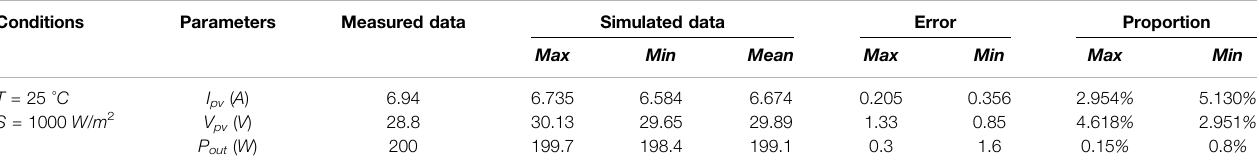
TABLE 2 | Error between measured data and simulated data under the standard conditions. Conditions